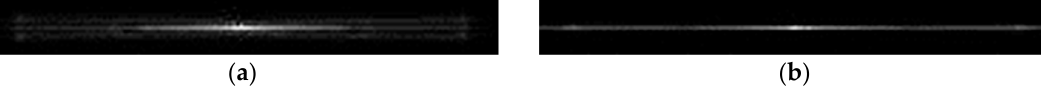
Figure 12. Block diagram of the FFT-based approach to the problem.